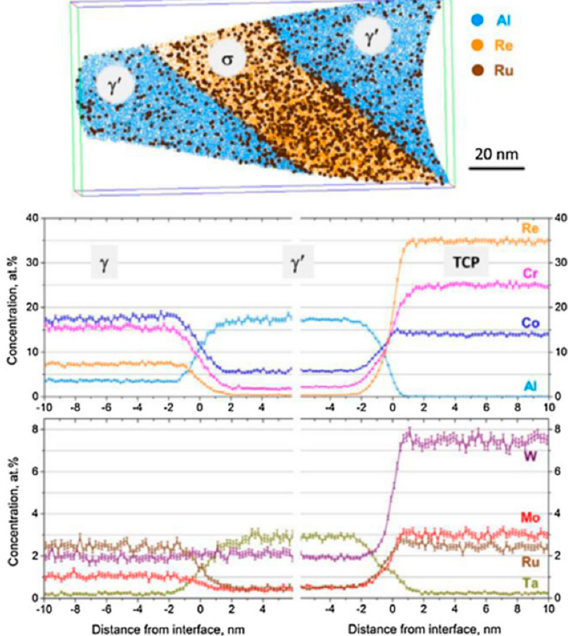
Figure 7. An APT elemental map of a plate-like σ precipitate surrounded by a γ ’ envelope (only Al, Re and Ru atoms are shown) and corresponding concentration profiles across γ / γ ’ and γ ’/ γ interfaces for the annealed Astra1-21 alloy. Accumulation of Cr, Mo, W and Re in the σ phase is visible. Ru concentrations in the σ phase and γ matrix are nearly identical. No elemental segregation at phase boundaries can be observed